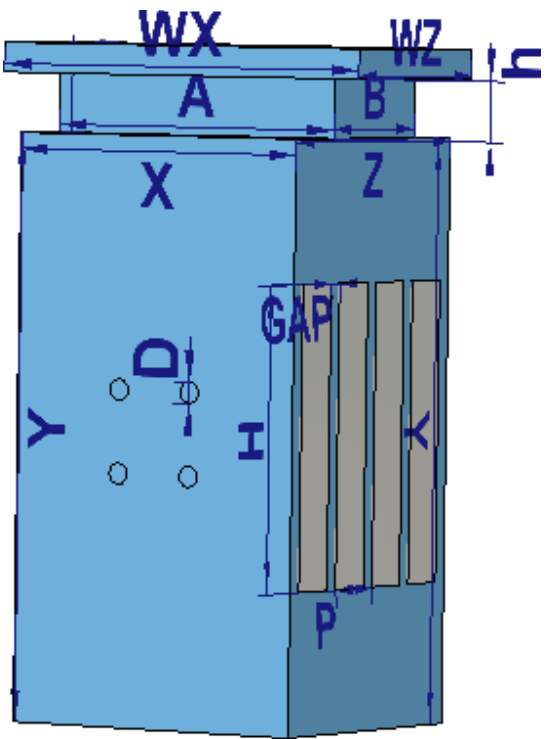
Figure 6. RF cavity considered for simulation: ladder-type multibeam EIK input/output cavities. Table 4. Optimized design parameters (input/ output cavities).